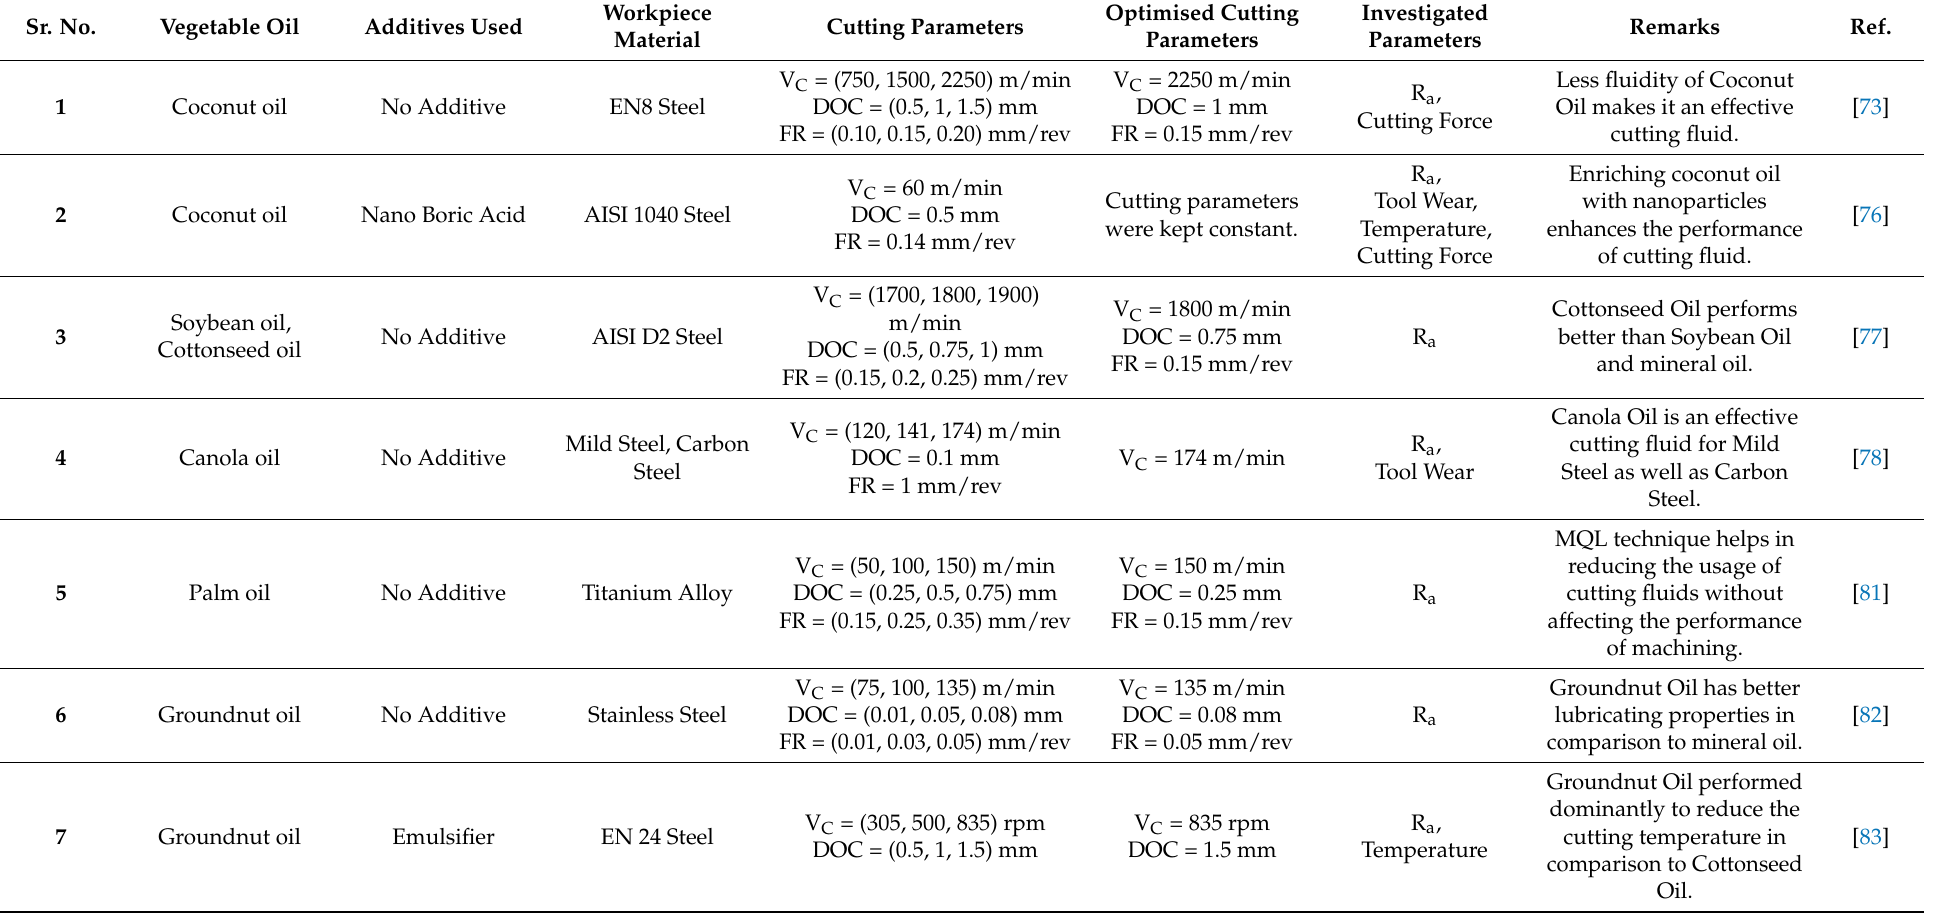
Table 1. Turning Operation Using Edible Vegetable Oil-Based Cutting